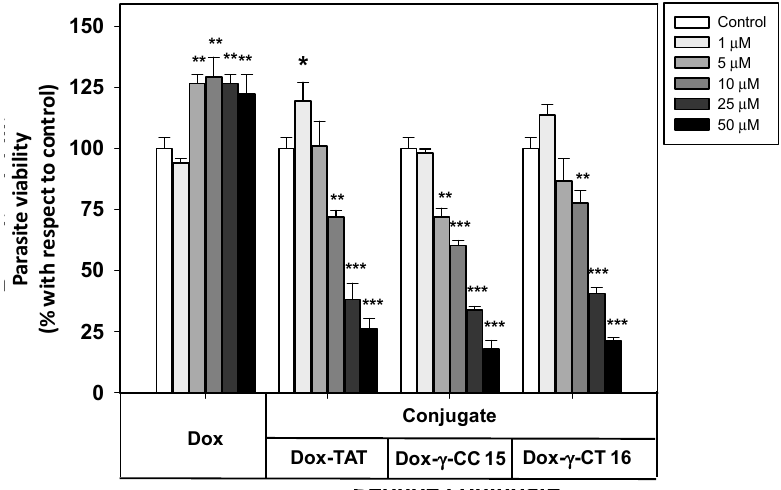
Figure 8. Viability of Leishmania donovani promastigotes treated with Dox-conjugates 15 and 16 along with Dox and Dox-TAT. Parasites were incubated with the respective reagents (20 × 10 6 cells / mL, 4 h, 26 ◦ C), and MTT reduction measured afterwards. Parasite viability was represented as the percentage of MTT reduction ± SD with respect to untreated parasites. Statistical significance with respect to control parasites: p ≤ 0.05 (*); p ≤ 0.01 (**); p ≤ 0.001 (***). Samples were made in triplicate. Results from one out of three independent experiments were represented.